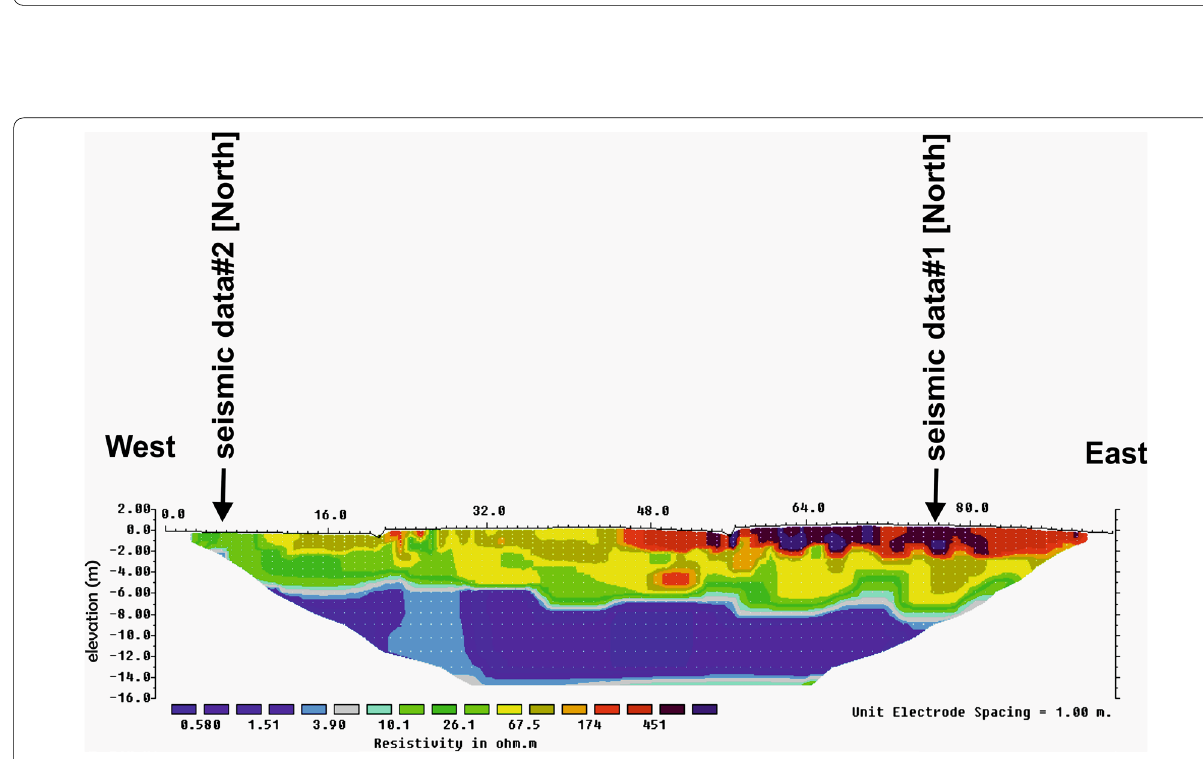
Fig. 10 Beligna#1 area—ERT survey: resistivity section perpendicular to the dune elongation (dipole–dipole configuration, 3200 measurements). Also shown the positions of the sites, where HV1-North and HV2-North were recorded (see Fig. 8a). See text for